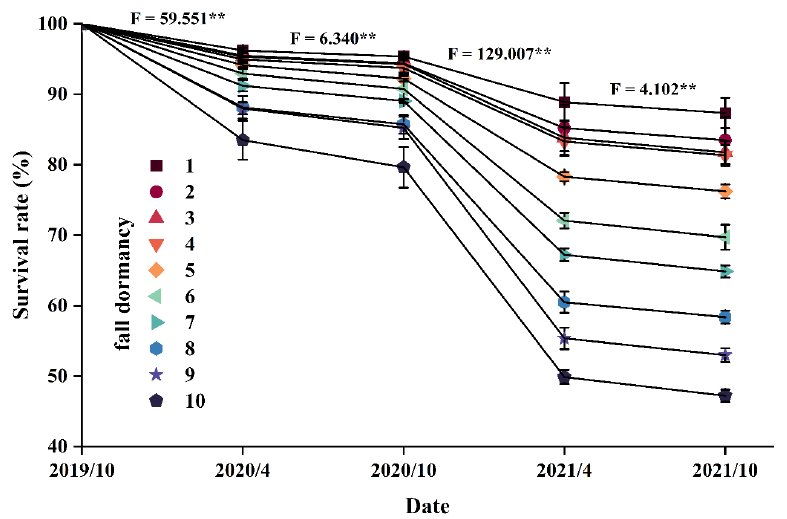
Figure 7. Comparison of survival rates of alfalfa with different fall-dormancy levels. F -values and p -values are ANOVA results for individual stage survival rates. ** indicates extremely significant difference between different fall dormancy levels ( p < 0.01).